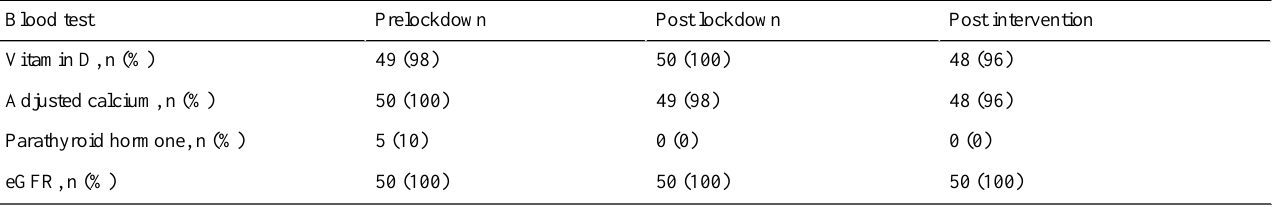
Table 2. Patients receiving blood tests according to guidelines during each phase, which includes vitamin D, parathyroid hormone, adjusted calcium, and estimated glomerular filtration rate (eGFR).